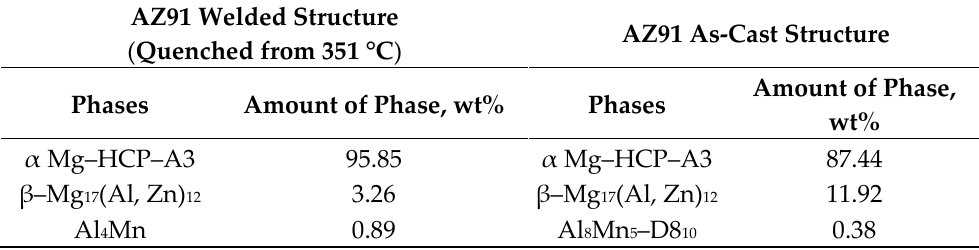
Table 5. Phase predictions for AZ91 at the maximum welding temperature and in the as-cast state.